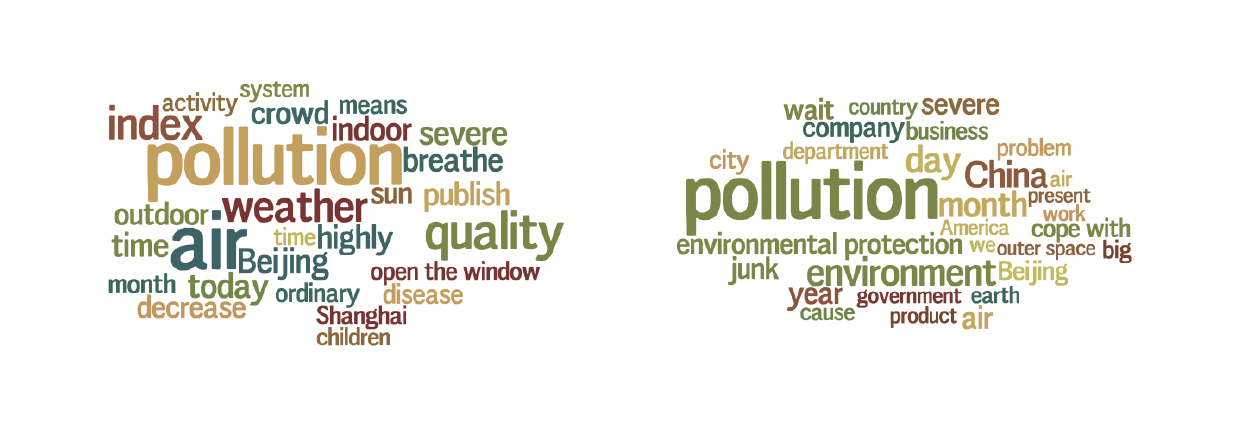
Figure 1. Two pollution-related topics learned from a probabilistic topic model. The left topic is about air quality, and the right topic is about pollution in